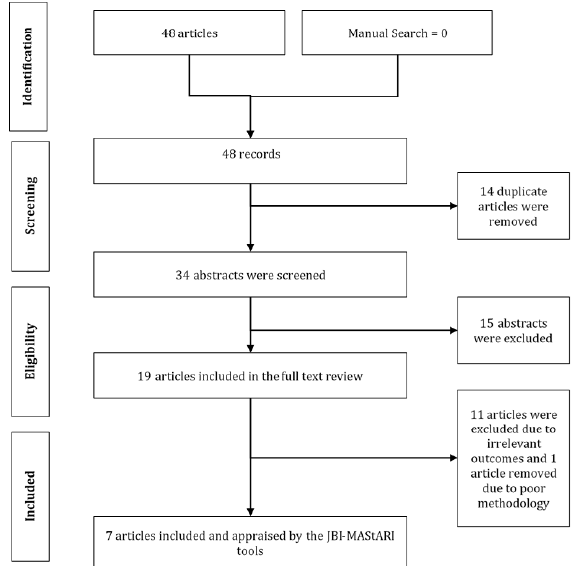
Figure 1. Quality appraisal of the included